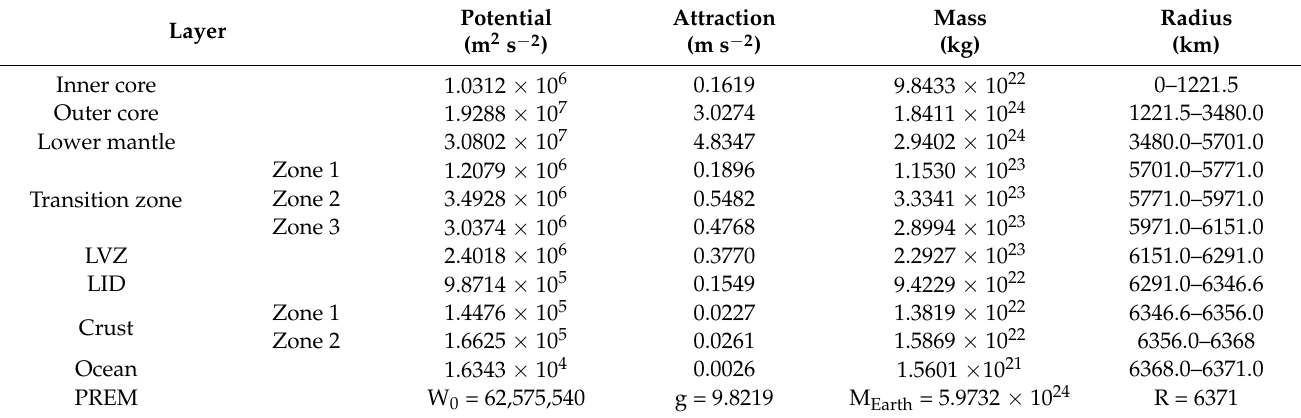
Table 3. Mass, gravitational potential and attraction of the PREM